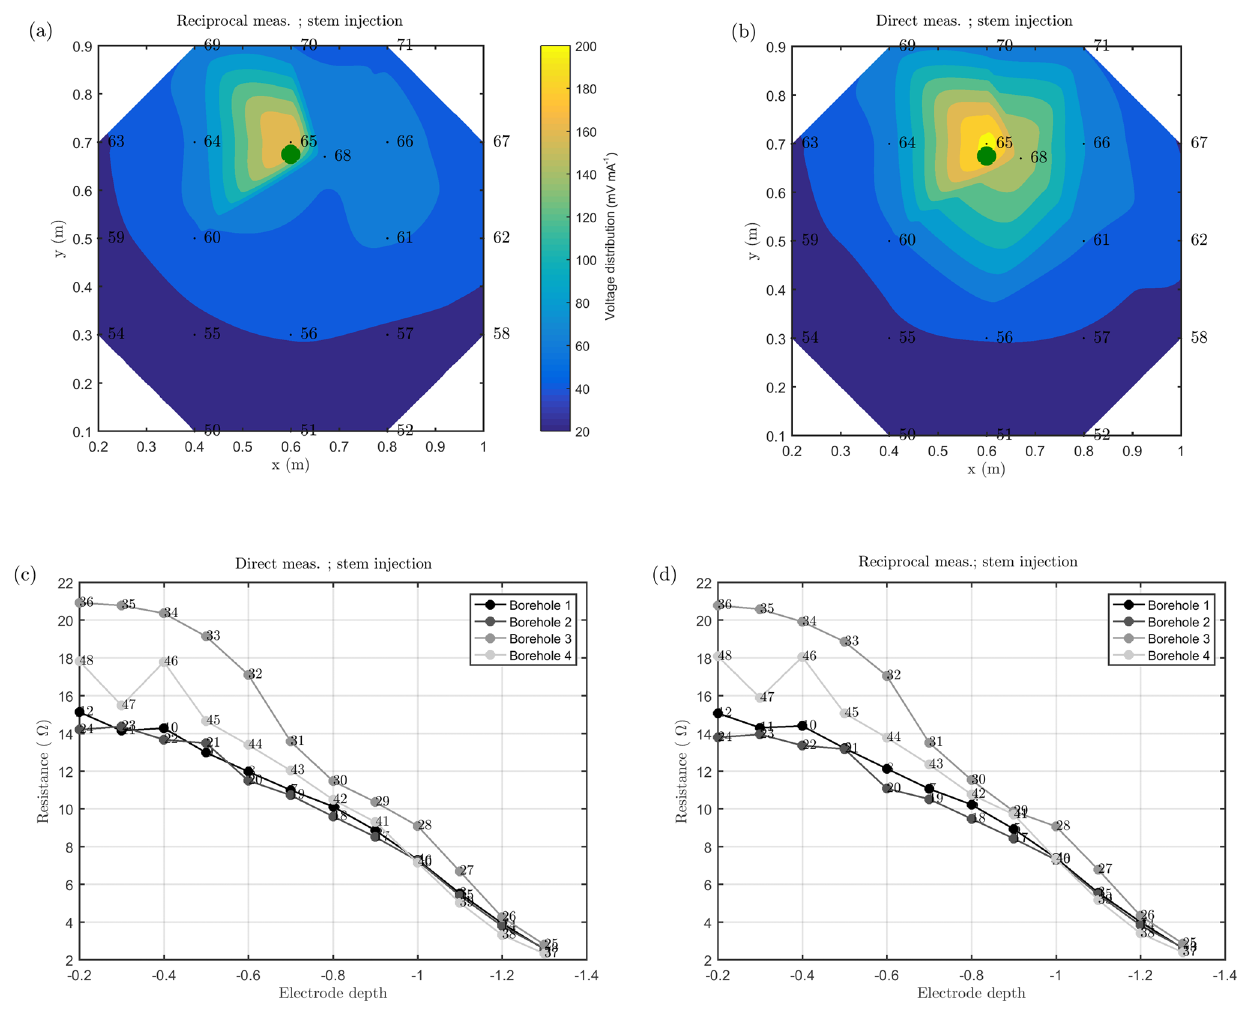
Figure A1. Spatial variations of the normalized voltage (I/U expressed in V/A) observed by surface electrodes ( a , b , interpolated points) and borehole electrodes (c, d) obtained during the MALM field measurements: direct measurements (current injected into the stem) are shown on the right, while reciprocals are shown on the left. The green dot shows the location of the plant stem (at x = 0 . 65m, y = 0 .